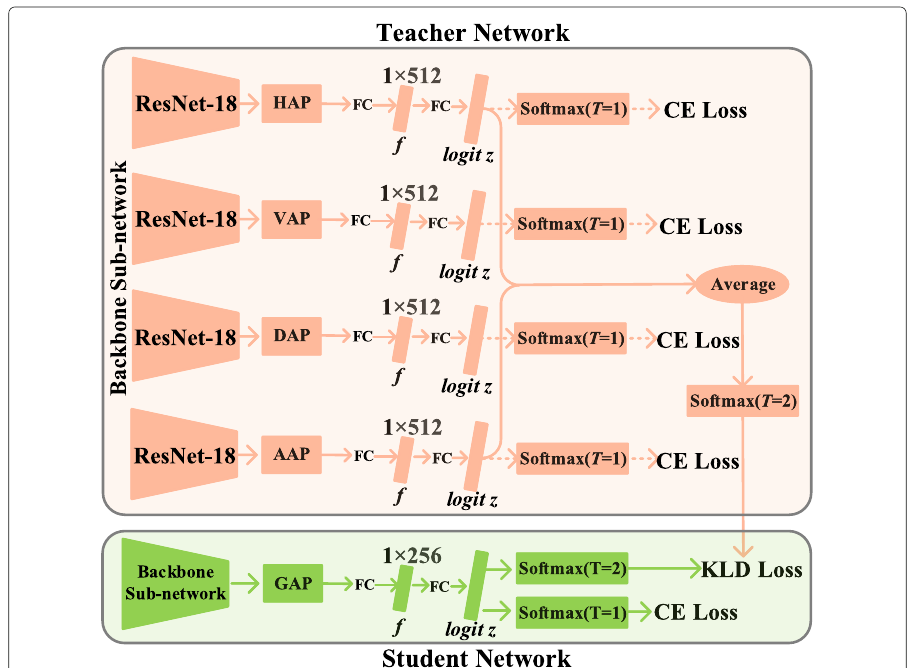
Fig. 2 The framework of the proposed viewpoint robust knowledge distillation method. FC represents a fully connected layer. Dotted arrows denote those components only work in the teacher network’s training